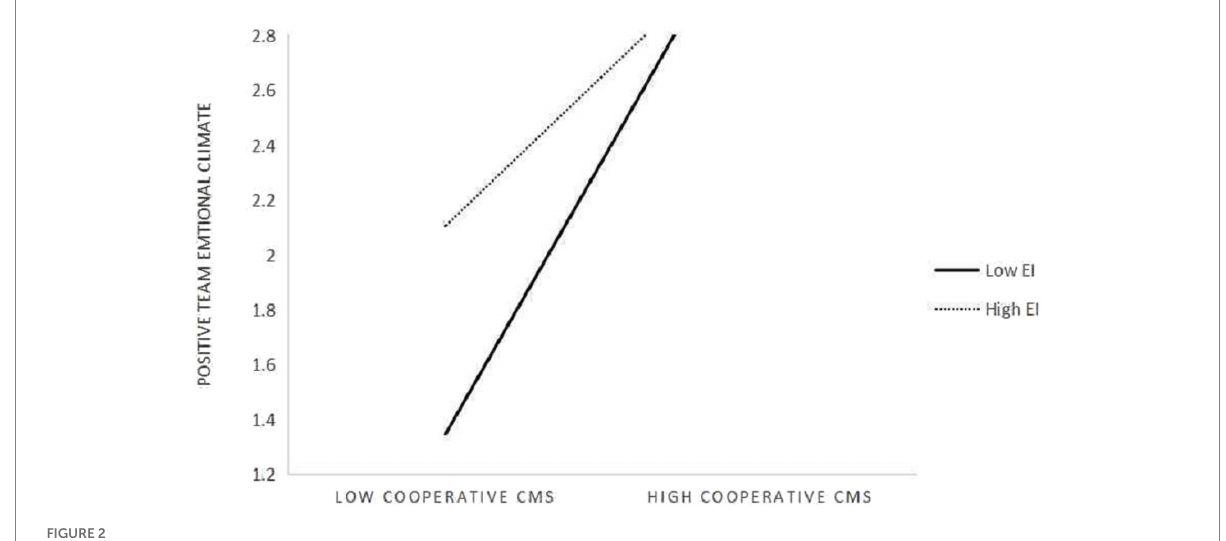
FIGURE 2 Cooperative styles × TEI influence on positive team emotional climate.